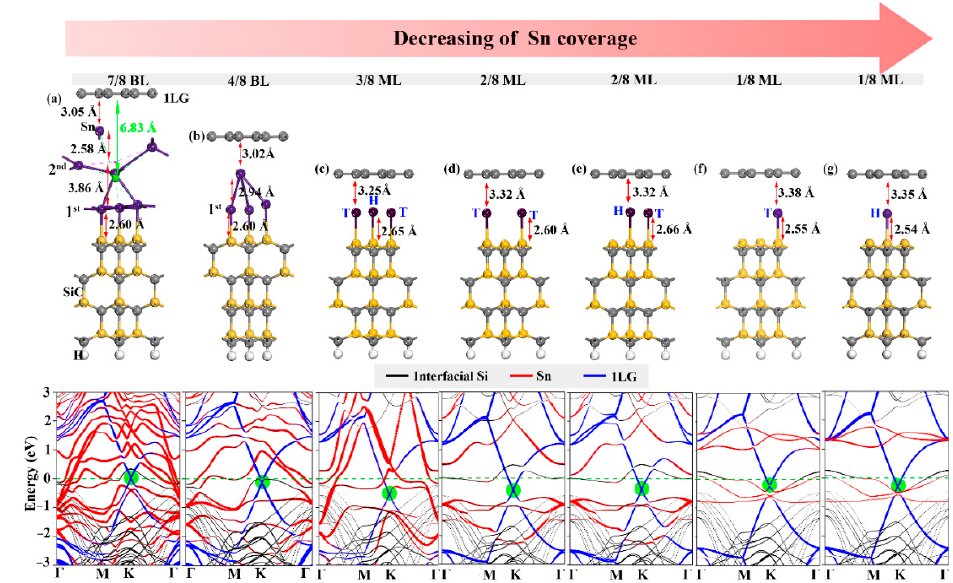
Figure 3. ( a – g ) Structures and band structures of 1LG/Sn/SiC with different Sn locations and coverages. The green ball in ( a ) represents the intercalated mass center of the Sn intercalation. In the band structures, the red, blue, and black lines represent the contribution of Sn intercalation, 1LG, and interfacial Si of SiC substrate, respectively. The green circles show the graphene Dirac